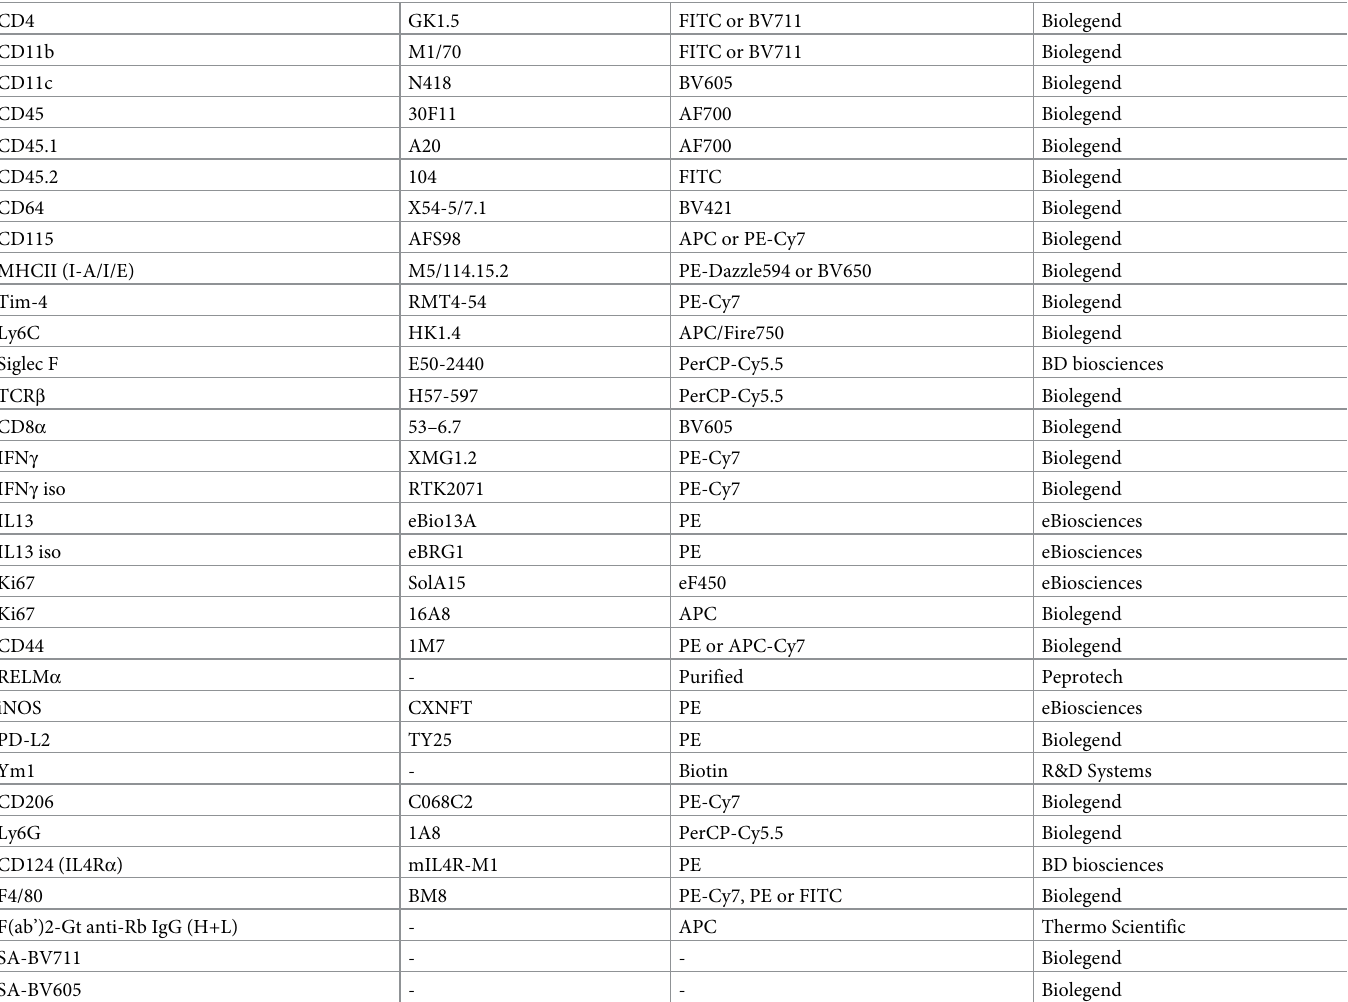
Table 1. Flow cytometry antibodies